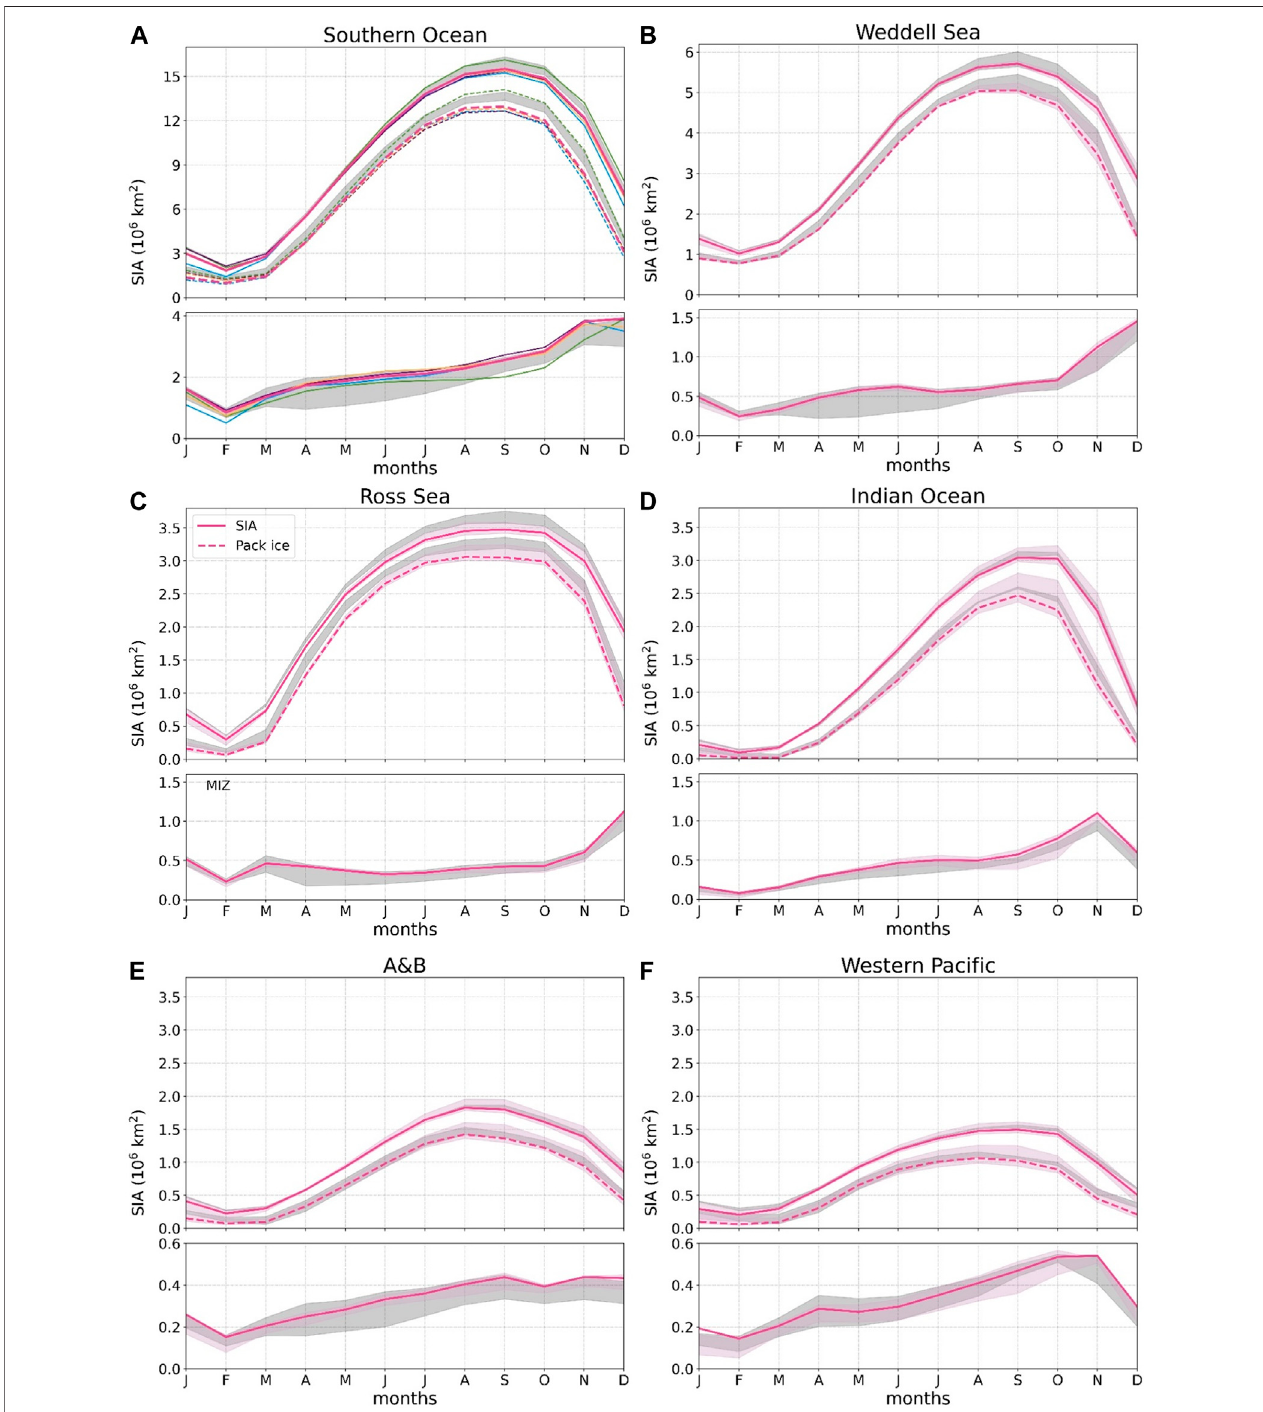
FIGURE 6 | Mean seasonal cycle (1993 – 2019) in the total SIA (solid), pack ice (dashed) (upper subplots), and the area covered by Marginal Ice Zone (MIZ) (lower subplots) computed for GREP (in magenta) and the individual ORA (thin colored lines) in the Antarctic-wide region (A) , for GREP in the fi ve sub-sectors (B-F) . Pink shading denotes the envelope of GREP members. Gray shading denotes the envelope of observational estimates (CDR, OSISAF, Ifremer CERSAT). Please note the different y-axis scales for the Southern Ocean and Weddell Sea.